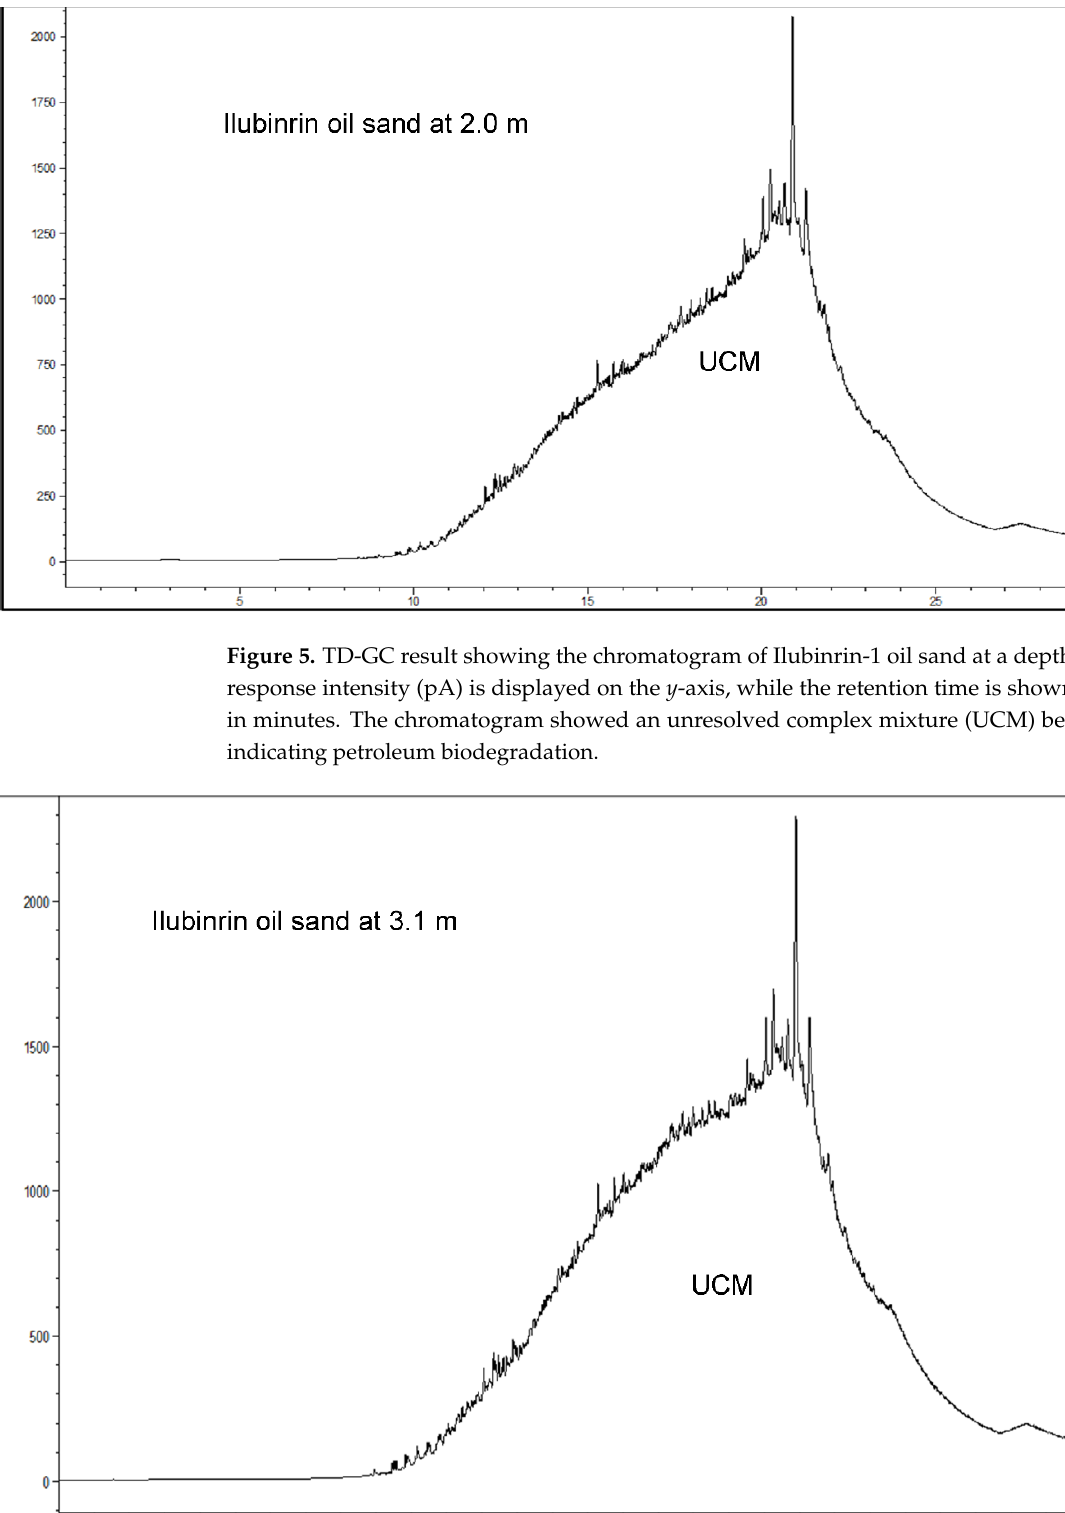
Figure 4. TD-GC result showing the chromatogram of Ode-Aye-1 oil sand at a depth of 4.1 m. The response intensity (pA) is displayed on the y -axis, while the retention time is shown on the x -axis in minutes. The chromatogram illustrated an unresolved complex mixture (UCM) below the peaks, indicating biodegraded oil.